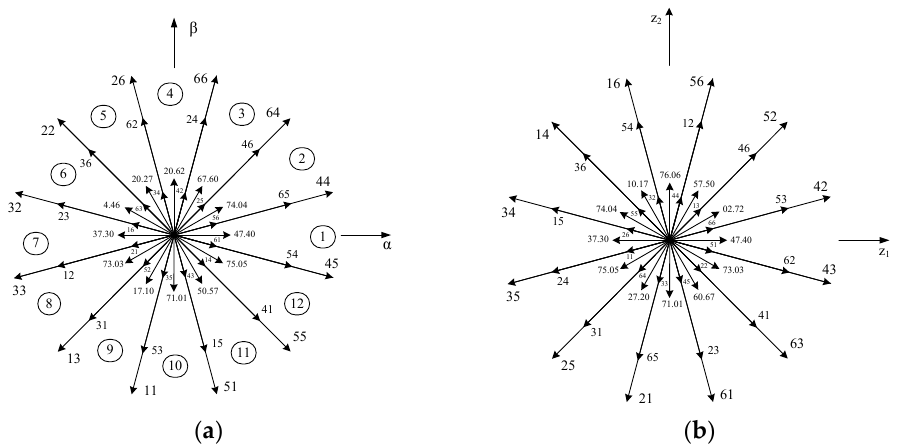
Figure 2. Diagram of six-phase inverter voltage vectors: ( a ) α − β subspace and ( b ) Z 1 − Z 2 subspace. Table 1. Amplitude of space vector for six-phase VSI. Voltage Vector Amplitude V L V